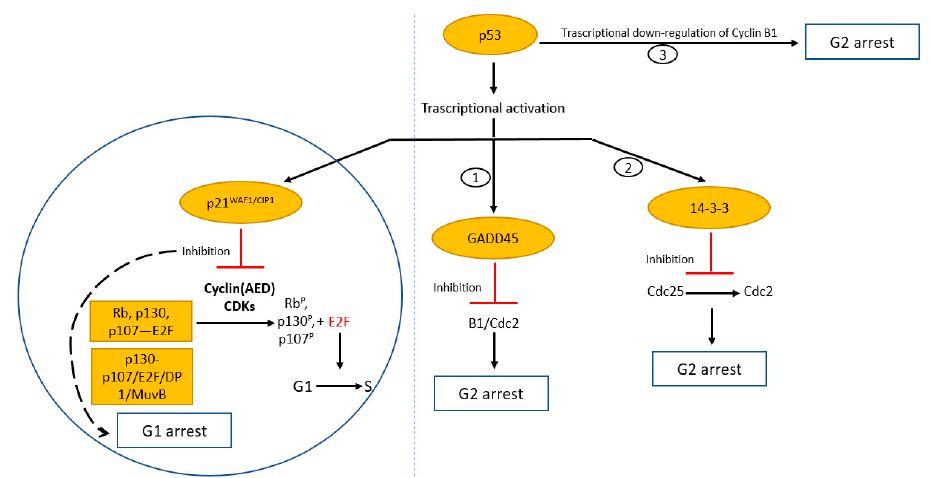
Figure 1. Cell cycle regulation by tumour suppressor p53. Evidence for both a G1 and G2/M checkpoint function. Transcriptional activation of p53 results in induction of p21WAF1/CIP1 that binds to and inhibits cyclin (AED)/cdk complexes. Hypo-phosphorylation of Rb and related proteins blocks E2F activity and concurs to the formation of the DREAM complex (p130/p107/E2F/DP1/MuvB), resulting in G1 arrest. Induction of GADD45 and 14-3-3 and repression of cyclin B1 cause cell cycle arrest in G2.